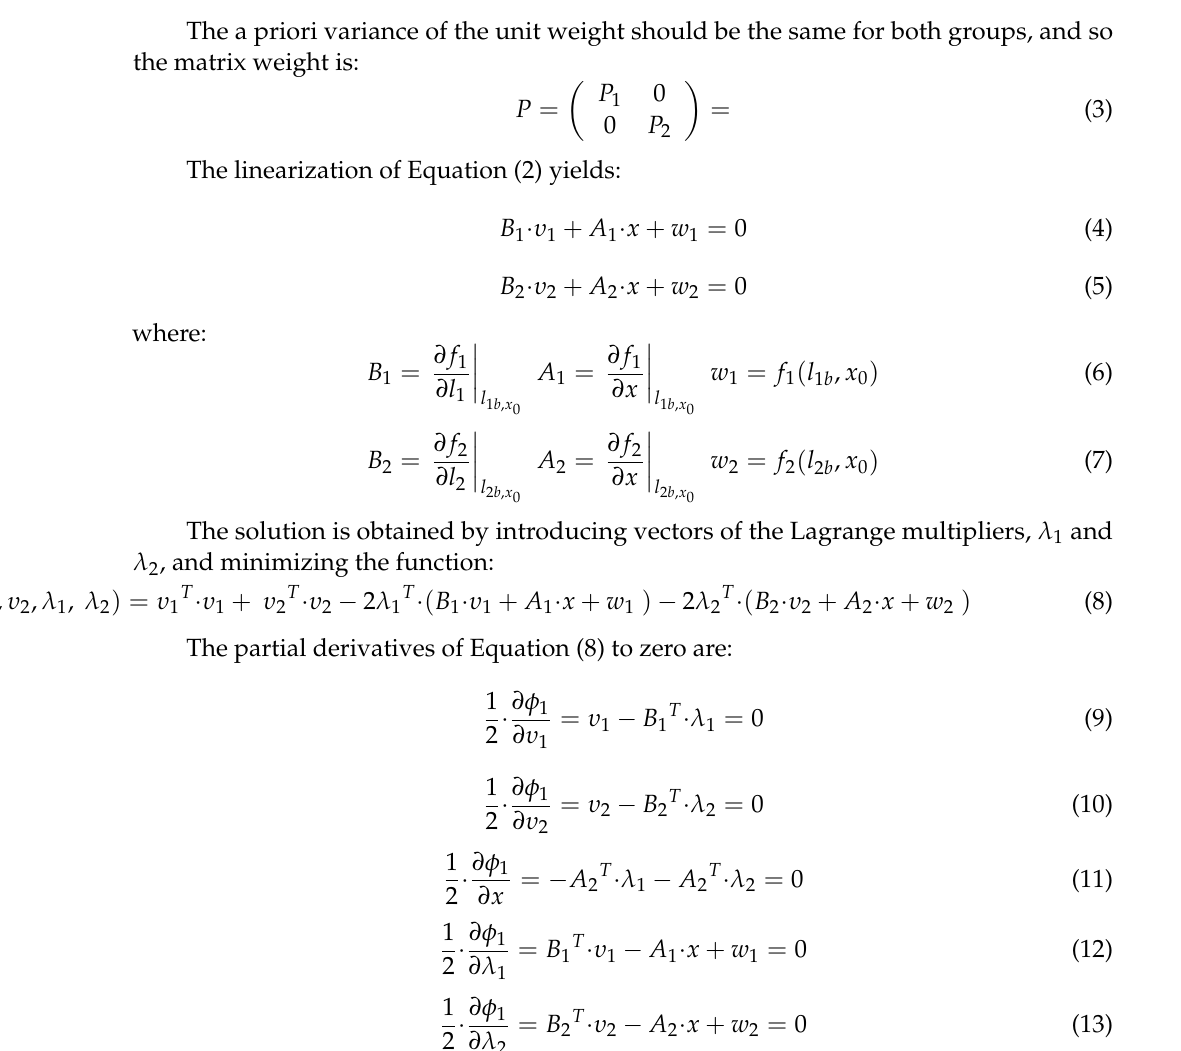
Figure 1. From left to right, two examples of global navigation satellite systems (GNSS) networks: ( a ) a five vertices network and ( b ) a three vertices